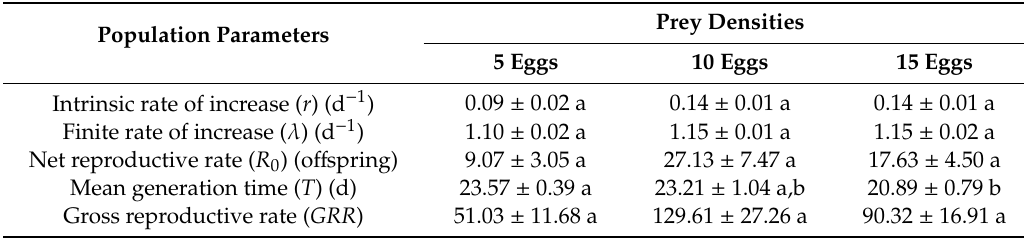
Table 4. E ff ect of three prey densities on the life table parameters of O. strigicollis feeding on P. gossypiella